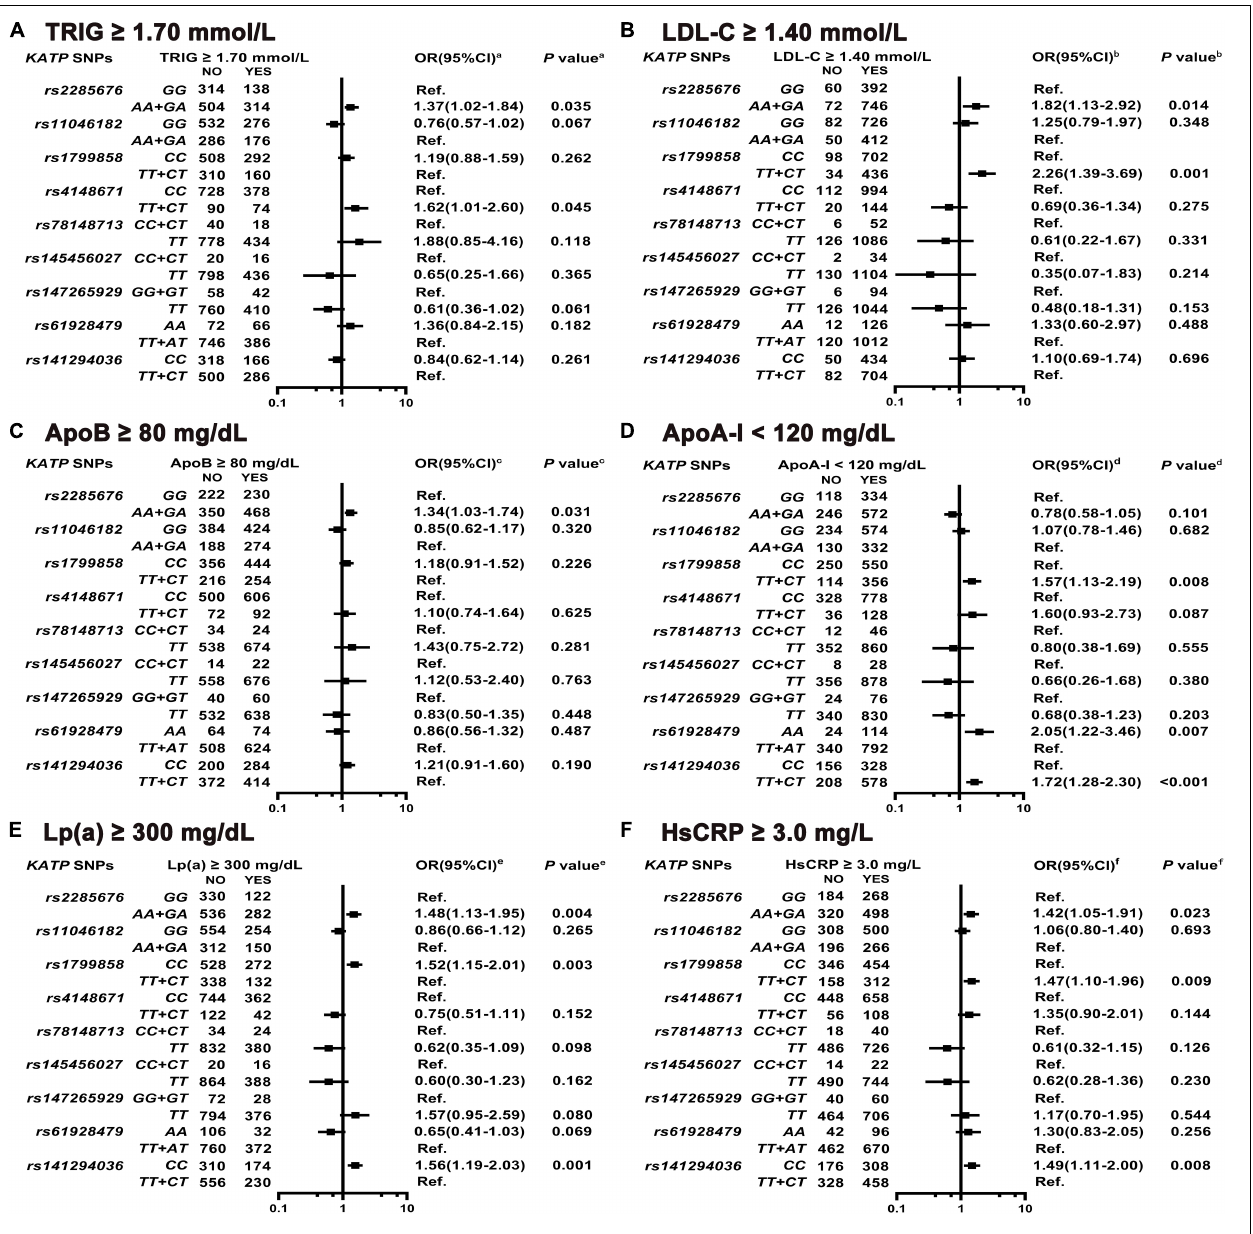
FIGURE 6 | Association of KATP SNPs with abnormal serum levels of blood lipid and HsCRP in the study participants. a Model (A) After adjustment for gender, age, smoking, alcohol consumption, BMI, WBC, T2D, SBP, DBP, blood glucose levels (FBS, P2hBS, and HbA1C), liver function (ALT, AST, and Alb), renal function (Scr, BUN, and UA), serum sodium and potassium levels, HsCRP, RAAS activity (ACE, renin, Ang I, Ang II, and ALD), and dyslipidemia [TC, LDL-C, ApoB, HDL-C, ApoA-I, and Lp(a)]. b Model (B) Is the same as Model 6a except LDL-C, and including TRIG. c Model (C) Is the same as Model 6a except ApoB, and including TRIG. d Model (D) Is the same as Model 6a except ApoA-I, and including TRIG. e Model (E) Is the same as Model 6a except Lp(a), and including TRIG. f Model (F) After adjustment for gender, age, smoking, alcohol consumption, WBC, BMI, T2D, SBP, DBP, blood glucose levels (FBS, P2hBS, and HbA1C), liver function (ALT, AST, and Alb), renal function (Scr, BUN and UA), serum sodium and potassium levels, HsCRP, dyslipidemia (TRIG, TC, LDL-C, HDL-C, ApoA-I, and ApoB) and RAAS activity (ACE, renin, Ang I, Ang II, and ALD).